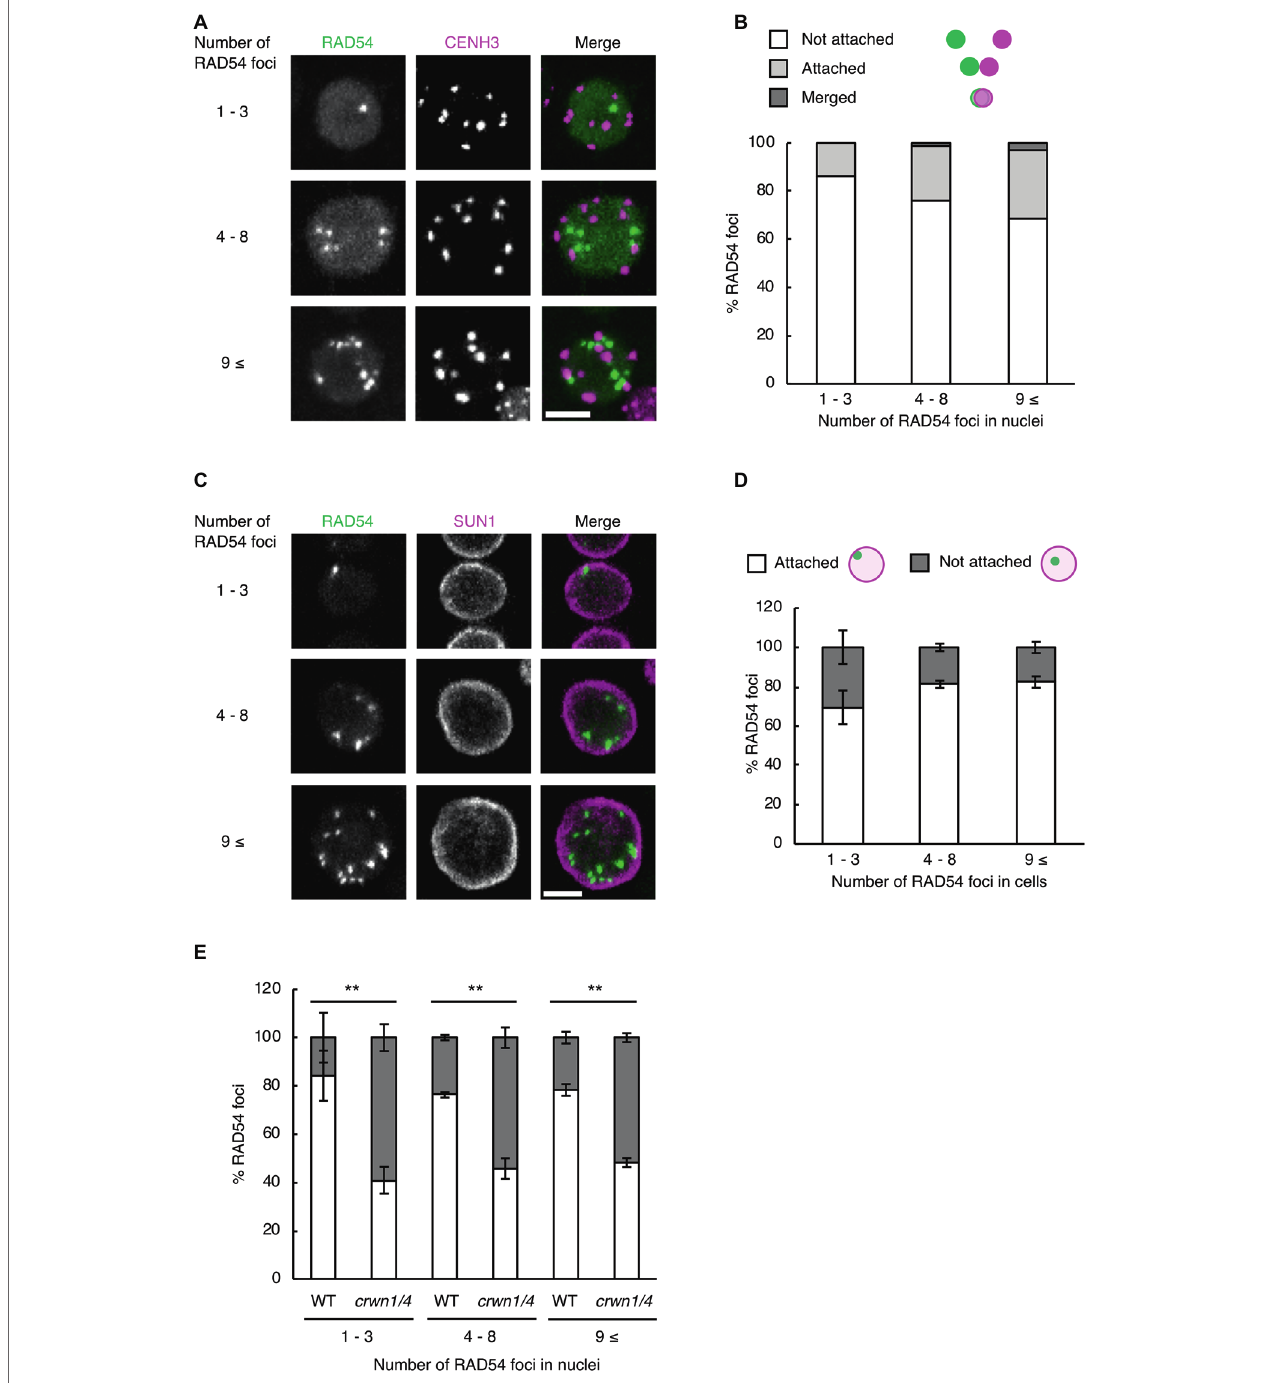
FIGURE 3 | RAD54 foci attached to the nuclear periphery are detected with high frequency at long time after γ -irradiation. (A) Nucleus of cells in the root meristematic zone in plants expressing RAD54-EYFP and CENH3-tdTomato at 24 h after γ -irradiation. Green: RAD54-EYFP. Magenta: CENH3-tdTomato. Scale bar: 5 μm. (B) Detection frequency of RAD54 foci interacted with CENH3 at 24 h after γ -irradiation. The interaction pattern between RAD54 foci and CENH3 were categorized in three classes (merged with CENH3, attached to CENH3, and not attached to CENH3; n = 74). (C) Nuclei of cells in the root meristematic zone in plants expressing RAD54-EYFP and SUN1-TagRFP at 24 h after γ -irradiation. Green: RAD54-EYFP. Magenta: SUN1-TagRFP. Scale bar: 5 μm. (D) Detection frequency of RAD54 foci attached and not attached to the nuclear envelope (NE) at 24 h after γ -irradiation. Error bars indicate the standard error. Three roots were counted for each group. (E) Detection frequency of RAD54 foci attached and not attached to NE in the wild type and the crwn1/4 double-mutant at 24 h after γ -irradiation. Error bars indicate the standard error. At least three roots were counted for each group. ** p < 0.01 (Fisher’s exact test). The perimeter of nuclei stained with DAPI was defined as the nuclear envelope in this